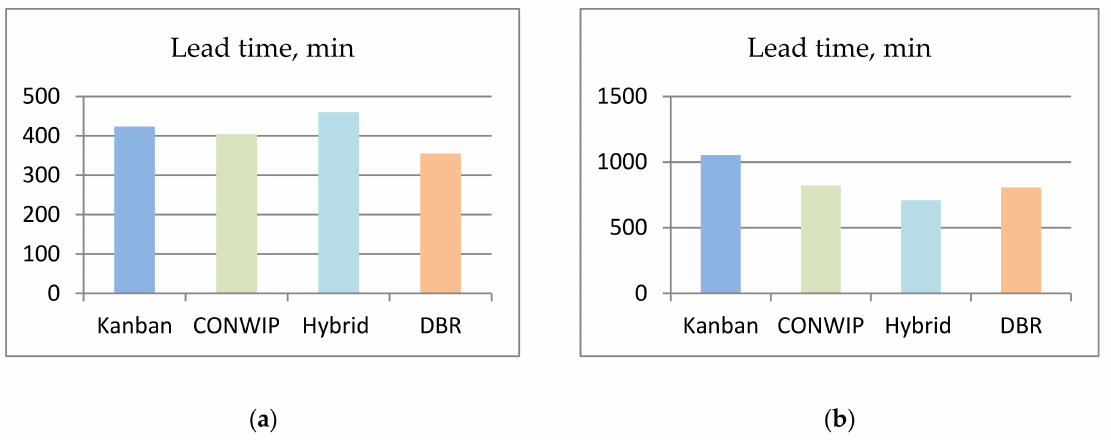
Figure 9. Comparison of the lead time for each control mechanism under the same production condition: ( a ) C V = 0.2 and T = 40 min for the process without bottleneck and WIP = 15; ( b ) C V = 0.2 and T = 40 min, for the process with bottleneck and WIP = 15.